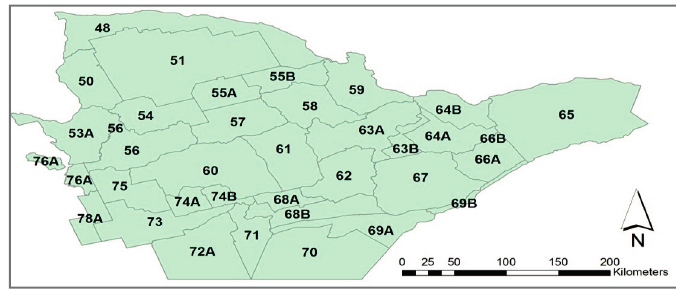
Figure 1. Wildlife management units in southeastern